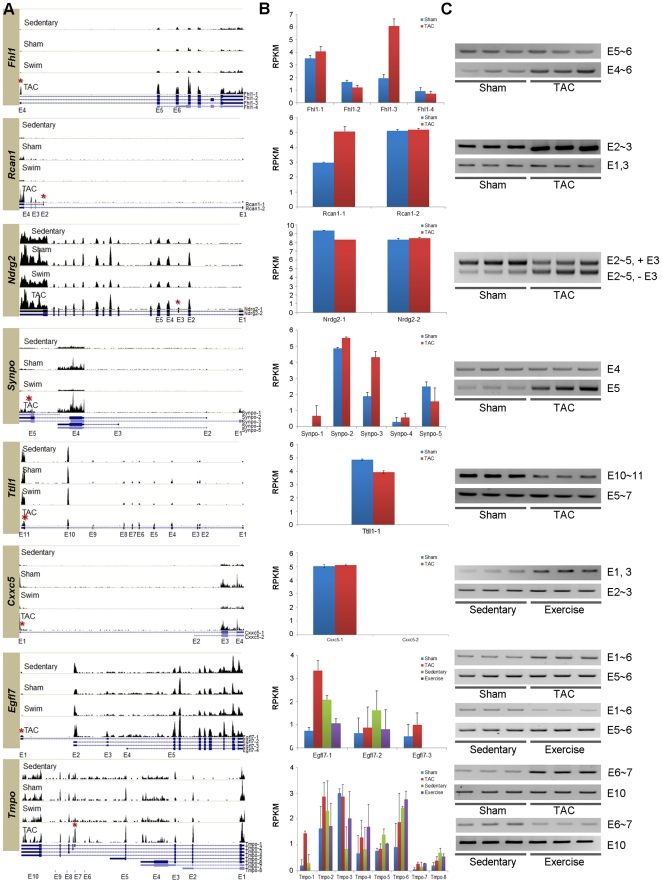
Experimentally verified isoforms alternatively spliced in PAH and PHH.(A) The histograms of mapped reads for 8 genes. The red asterisks shown at UCSC isoforms (blue lines underneath) indicate the exons (shown as blue boxes) alternatively spliced in hypertrophic signal-specific manners. The degree of expression is shown as vertical length. (B) Distribution of UCSC isoforms for the matching 8 genes characterized in different hypertrophy models. Different distribution of isoforms in either PAH or PHH was analyzed using NEUMA. The average RPKM values are shown with standard errors (N = 3). (C) Experimental confirmation of exon variants for the matching 8 genes using RT-PCR. For each RT-PCR results, the amplified regions with the specific primers are described. The detailed information for the primers used for the detection of the exons is available in Table S2. Fhl1, Rcan1, Ndrg2, Synpo and Ttll1 were experimentally confirmed in PAH and the splicing pattern of Cxxc5 exon variants was confirmed in PHH. For Egfl7 and Tmpo, the opposite splicing patterns were confirmed for both PAH and PHH. The isoform distributions of Ttll1 and Cxxc5 were not analyzed, since the UCSC isoforms for Ttll1 is not reported and there were no mappable reads for Cxxc5-2. The exon numbers amplified are indicated on the right. For instance, E5∼6 means exon 5 and 6 were amplified with specific primers shown in Table S2. For Ndrg2, two isoforms (E2∼5, +E3 and E2∼5, −E3) were shown in the same gel.